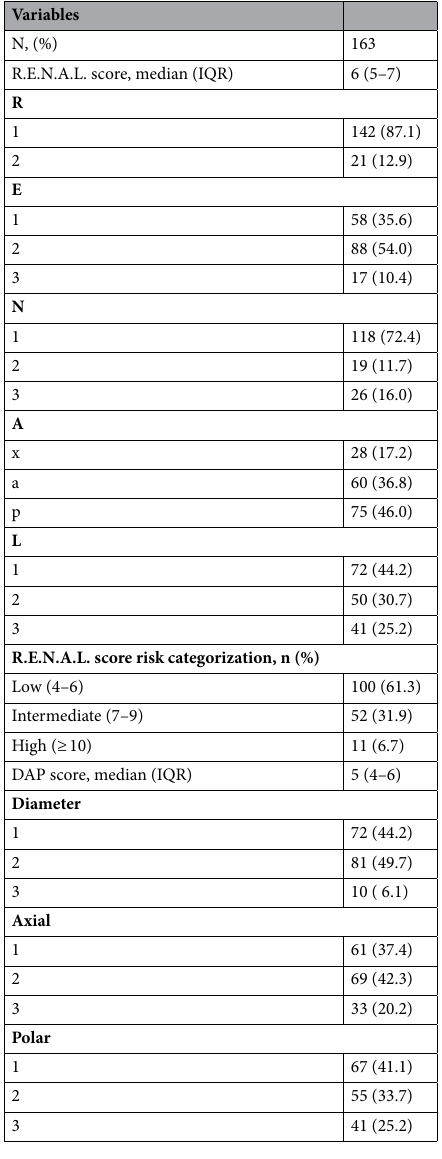
Table 2. Nephrometry scores. R.E.N.A.L. Radius, exophytic/endophytic, nearness to collecting system or sinus, anterior/posterior, and location relative to polar lines; DAP diameter-axial-polar; IQR interquartile